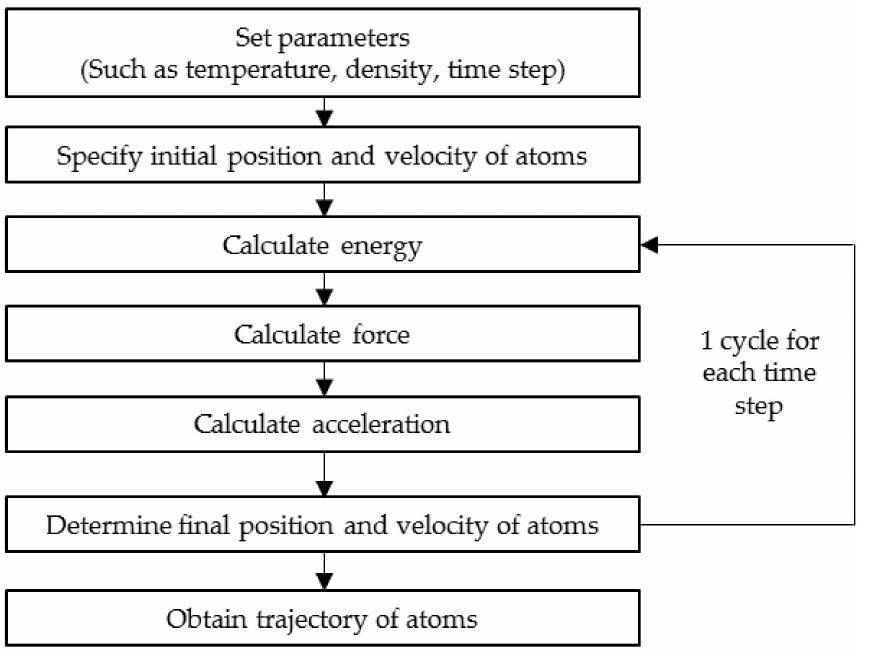
Figure 2. Computational flow of molecular dynamics